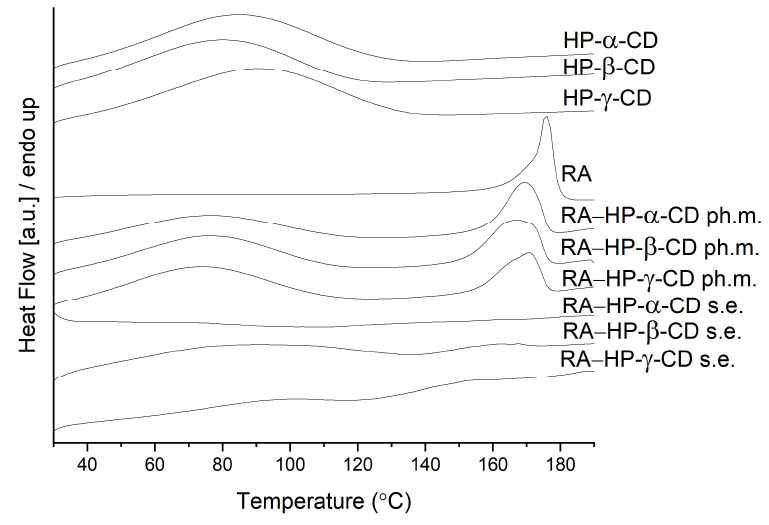
Figure 3. The DSC analysis of HP-α-CD, HP-β-CD, HP-γ-CD, RA, physical mixtures: